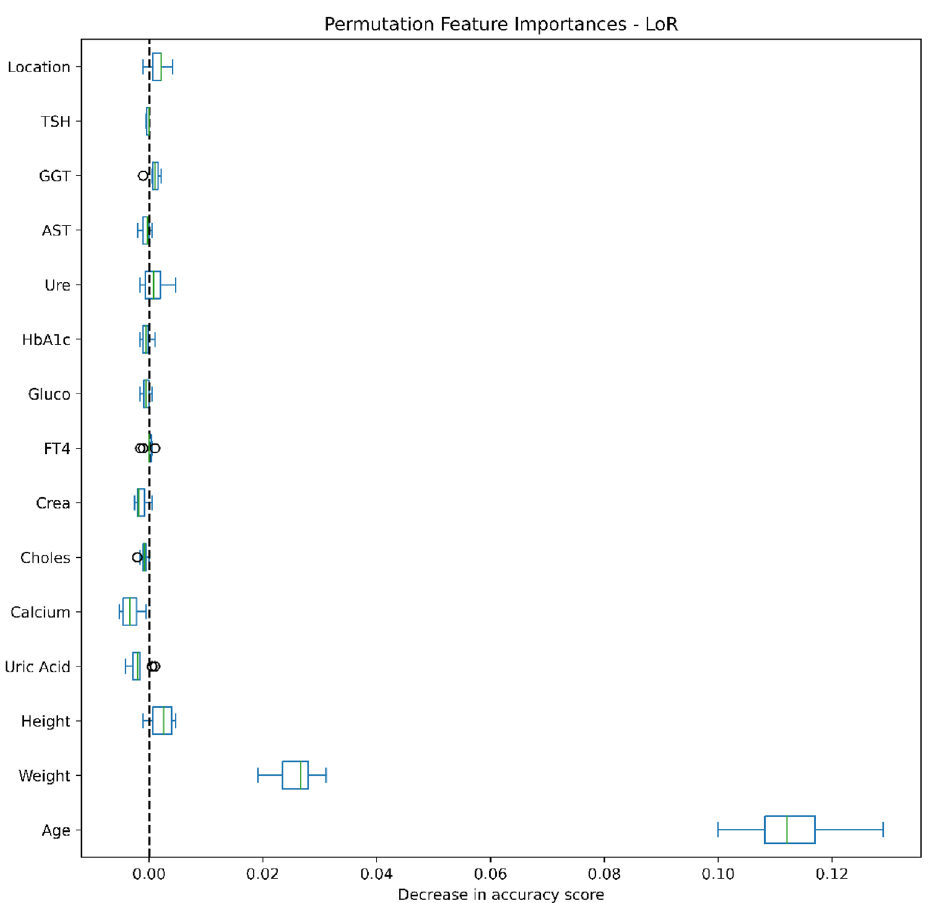
Figure 4. Feature importance for LoR in the first